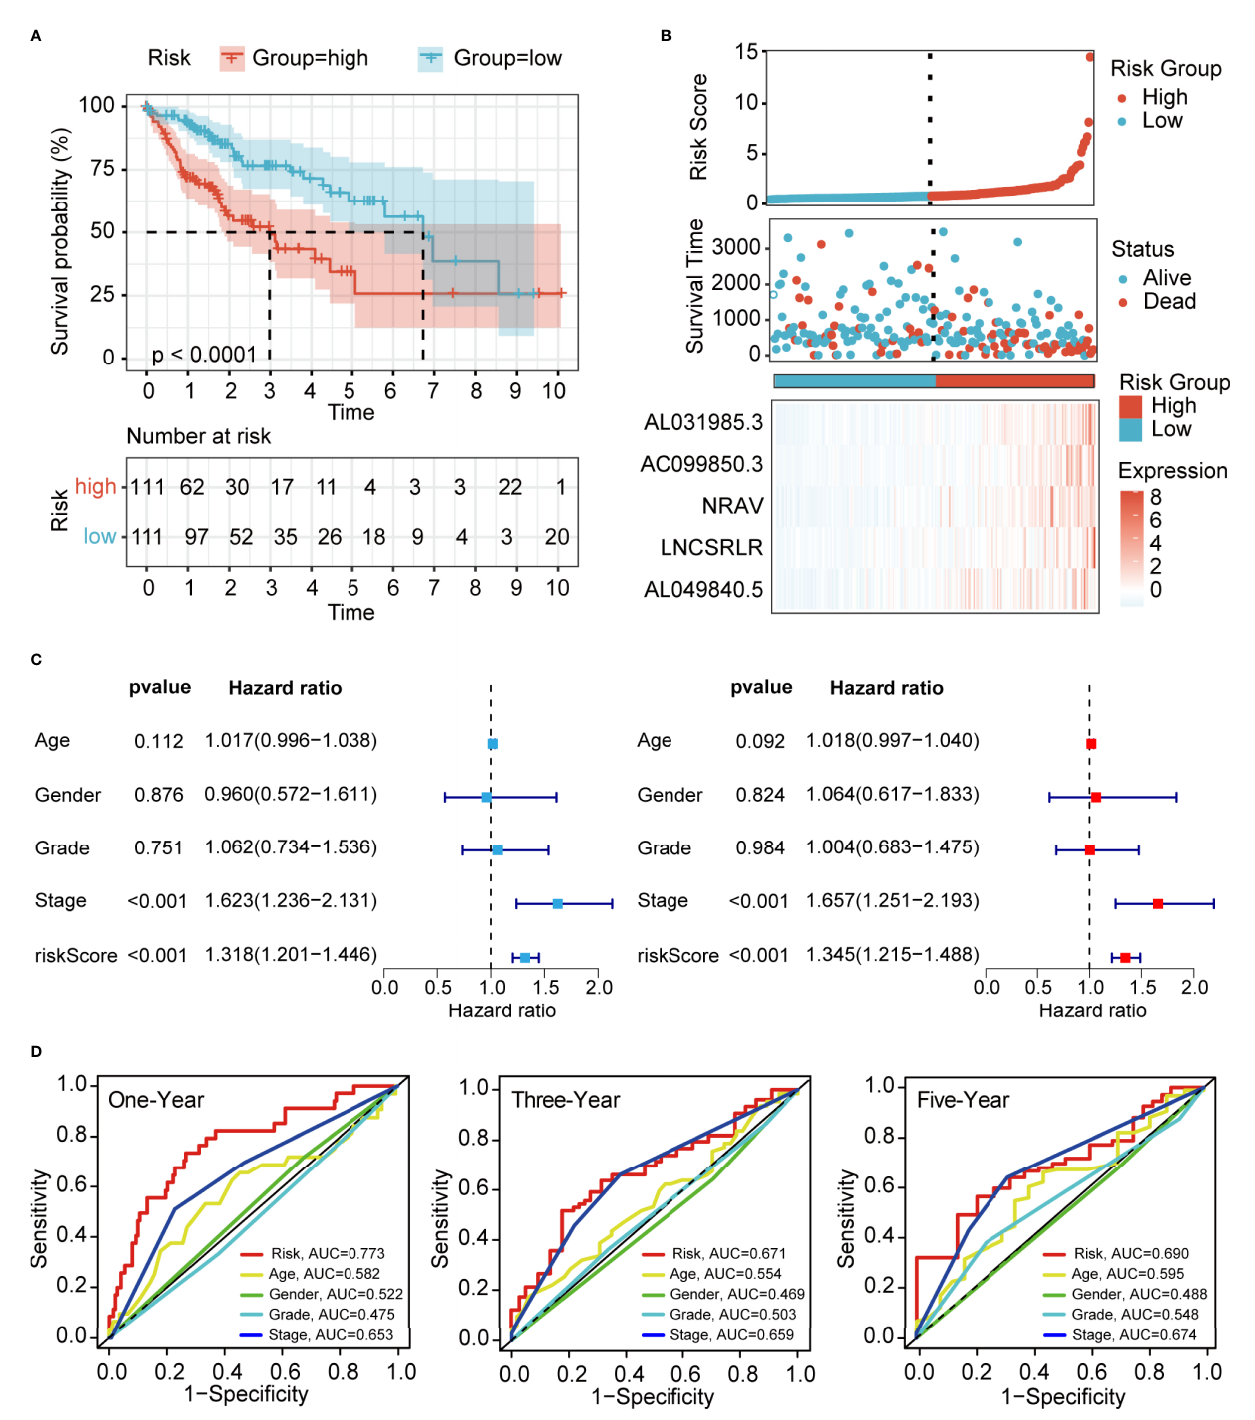
FIGURE 3 | Evaluation of the prognostic value of ferroptosis-related lncRNA signature in the training cohort. (A) Kaplan – Meier curves for the OS of patients in different groups ( p < 0.0001). (B) Risk curve of the risk score rank, scatter plot for the survival status distribution, and expression pro fi les of 5 ferroptosis-associated lncRNAs. (C) Univariate and multivariate Cox analyses for the independent prognostic predictor in the training cohort. (D) Multivariate ROC curves to predict the sensitivity and speci fi city of 1-, 3-, and 5-years survival in the training cohort. LncRNA, long non-coding RNA; OS, overall survival; ROC, receiver operating